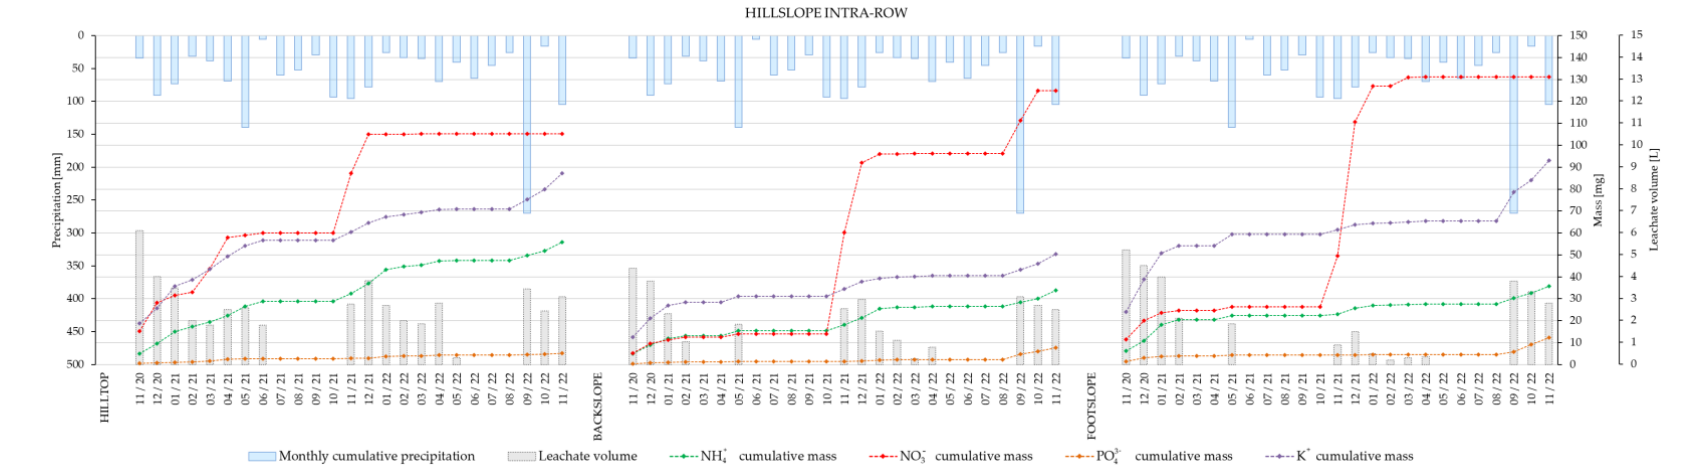
Figure 3. Nutrient ions cumulative masses in leachates, collected for two years (2 November 2020 to 25 November 2022) from wick lysimeters installed at hilltop, backslope and footslope of vineyard intra-row, presented with monthly cumulative precipitation and leachate volumes per sampling event.